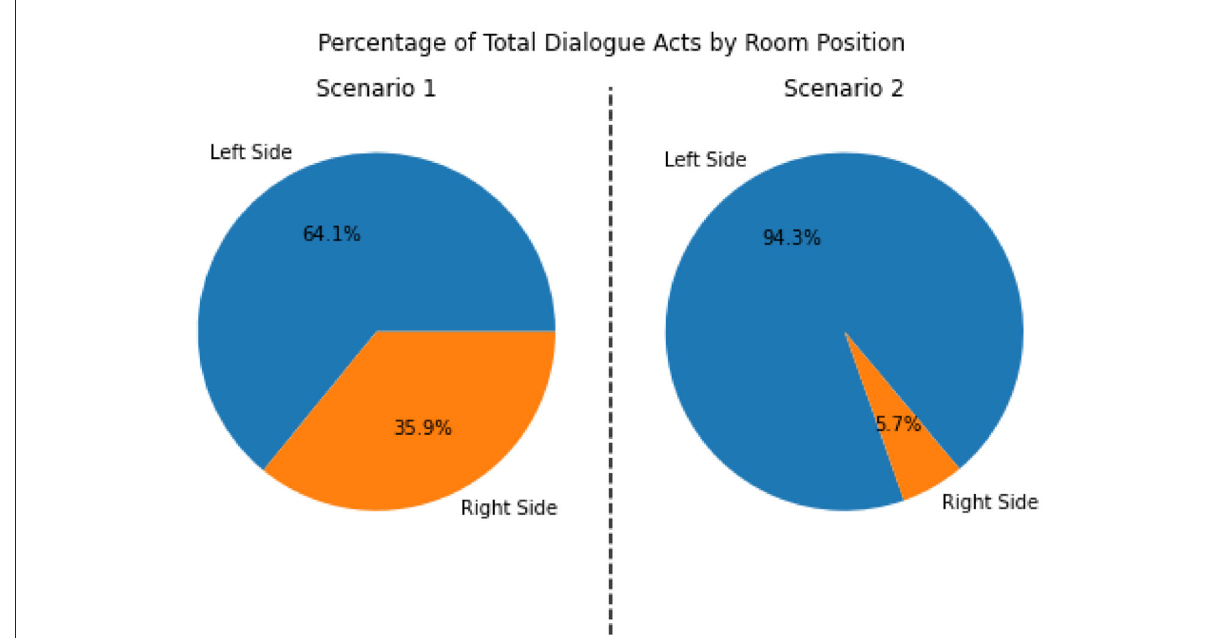
FIGURE12 Distribution of total speech acts conditioned on the nurse’s position in the room for each scenario.